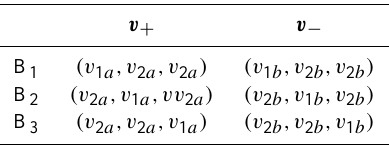
Table A1. Coordinates of the directional vectors on bisector B 1 , B 2 and B 3